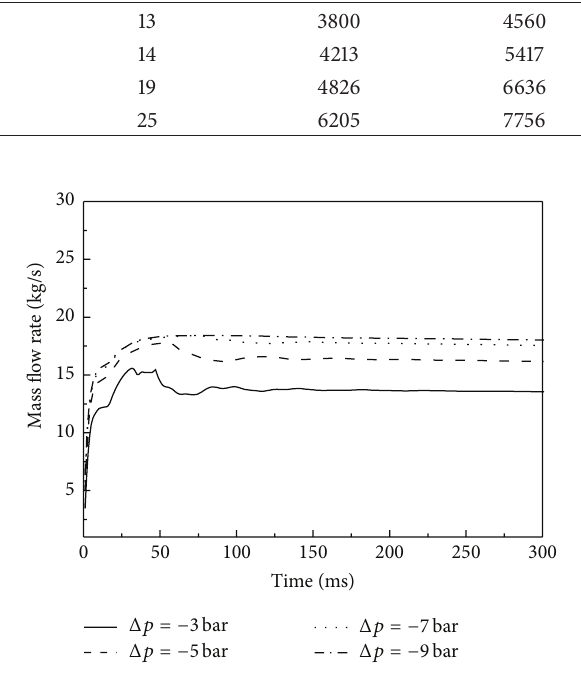
Figure 5: Pressure differential on the wall of thermal sleeve.